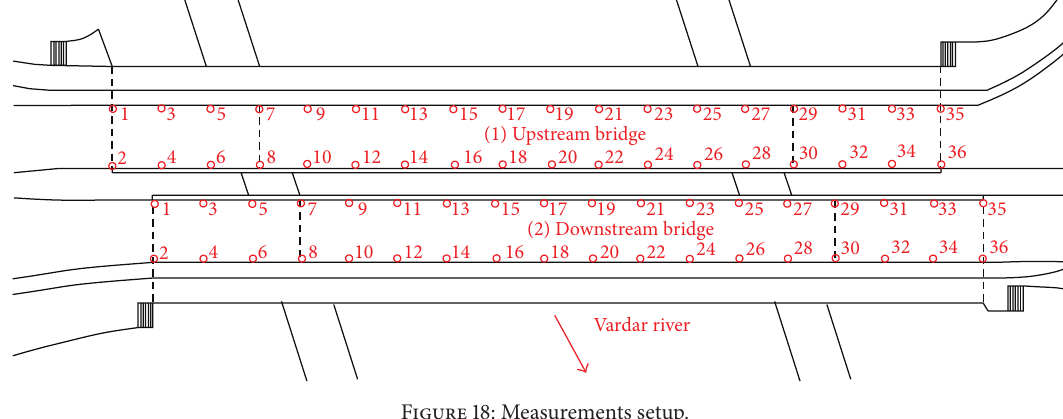
Figure 18: Measurements setup.